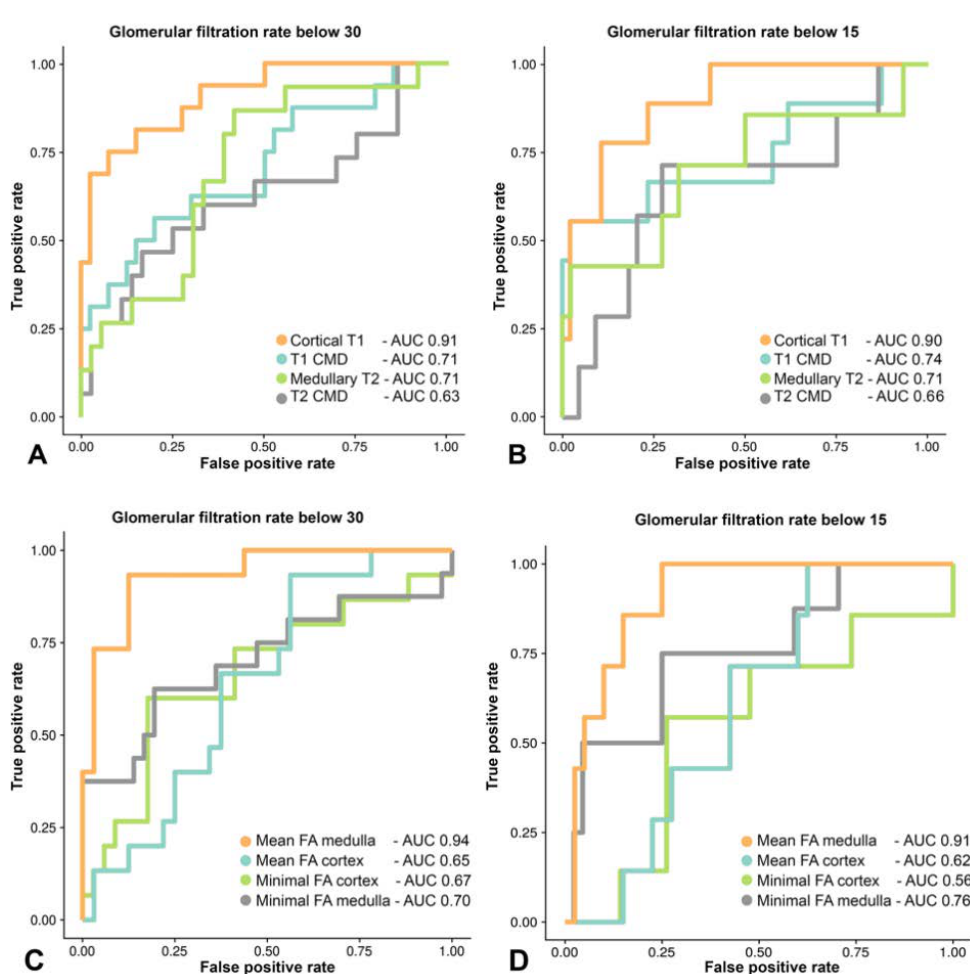
Figure 4. The Area under the Receiver Operating Characteristic Curve (AUC) for distinguishing glomerular filtration rates below 30 ( A , C ) and below 15 ( B , D ) from better functioning kidneys was highest for cortical T1 (AUC of 0.91 or 0.90) ( A , B ) and mean medullary FA values (AUC of 0.94 or 0.91) ( C , D ).